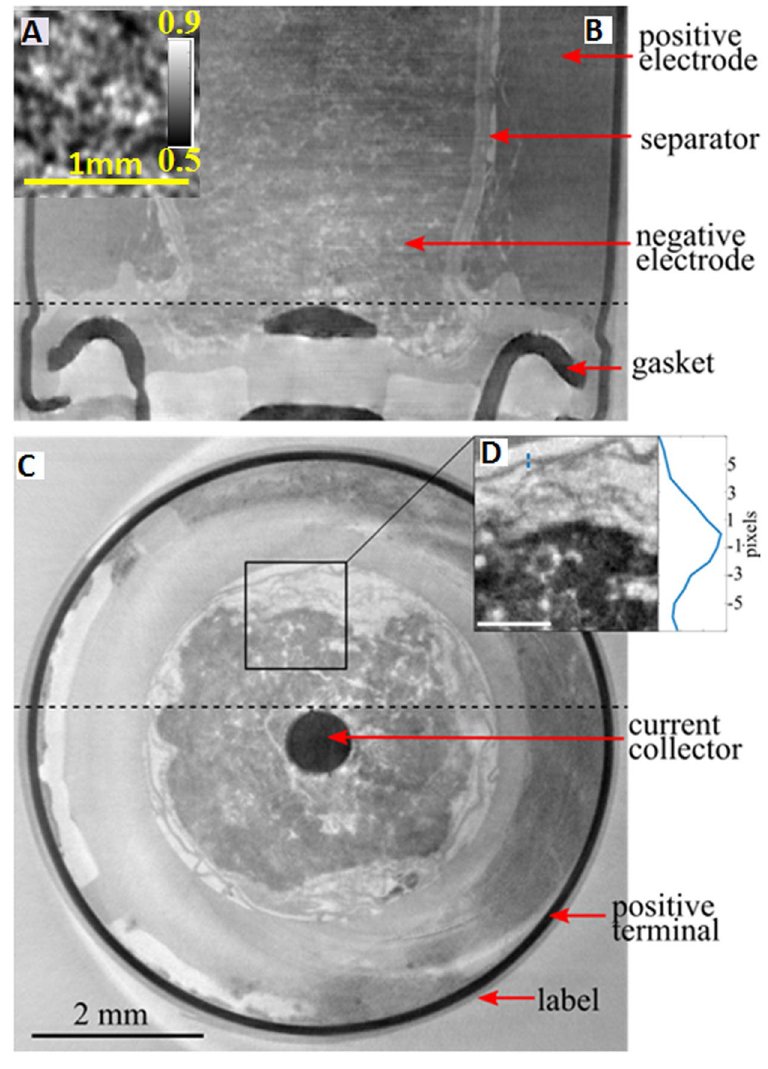
Figure 6. Reconstructed axial ( B ) and sagittal ( C ) slices of a battery sample from position indicated by dashed lines. ( A ) A raw speckle image after the flat field correction, and the visibility is 14% at 120 keV. ( D ) A magnified image of the small square region at bottom, shows coarse layers of particles from the separator and the negative electrodes. The scale bar at the bottom of the inset is 0.5 mm. The profile is taken from the inset where the blue line is